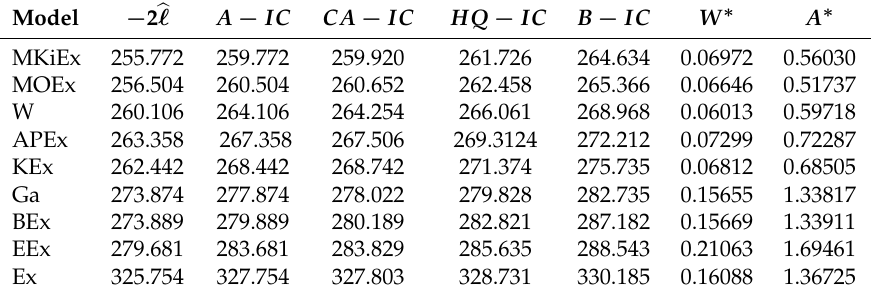
Table 5. Numerical values of the analytical measures for data set I.